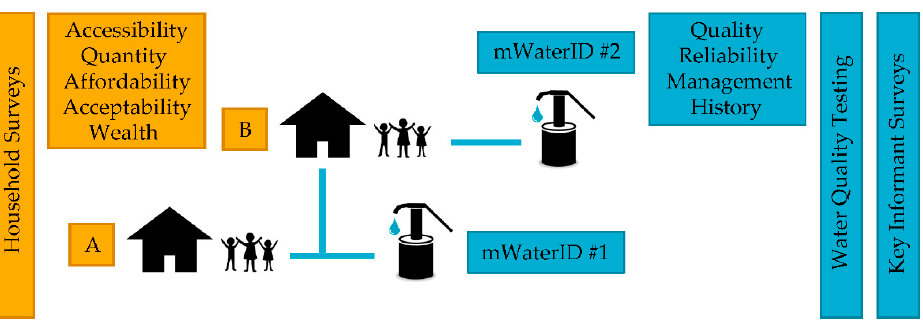
Figure 2. Data aggregation diagram.